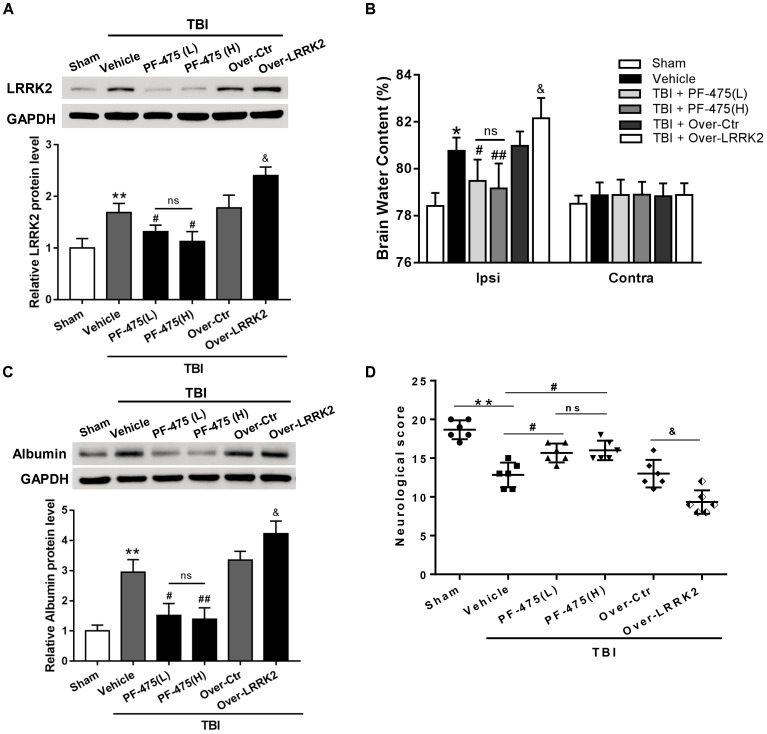
Effects of LRRK2 intervention on neurological score, brain edema, and BBB integrity after TBI. (A) Western blot analysis was conducted to assess the efficiencies of LRRK2 intervention in the pericontusional cortex at 12 h after TBI. (B) The brain water content of the bilateral hemispheres of the different groups was measured using the wet–dry method. (C) Western blots showing the levels of albumin extravasation in the pericontusional cortex at 12 h after TBI. (D) Representative neurological behavior scores from the modified Garcia test in the experimental groups at 72 h after TBI are shown. Statistical analyses were performed using one-way ANOVA followed by Tukey’s post hoc test. Data are presented as the mean ± SD, n = 6 animals per group. ∗P < 0.05, ∗∗P < 0.01 vs. sham; #P < 0.05, ##P < 0.01 vs. the Vehicle group; &P < 0.05 vs. the Over-Ctr group. Ipsi indicates the ipsilateral injured hemispheres; Contra, contra-lateral uninjured hemispheres.